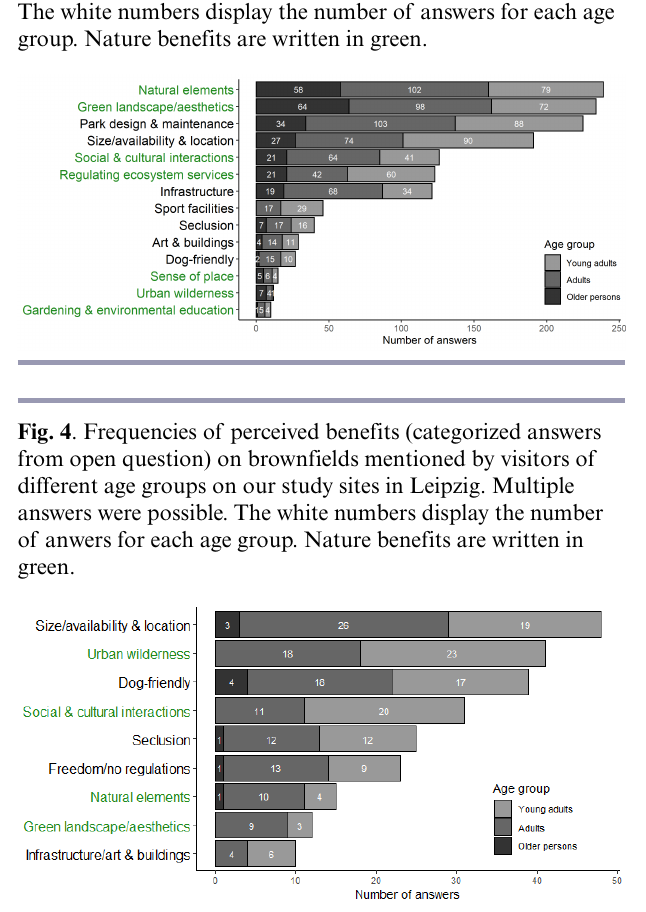
Fig. 3 . Frequencies of perceived benefits (categorized answers